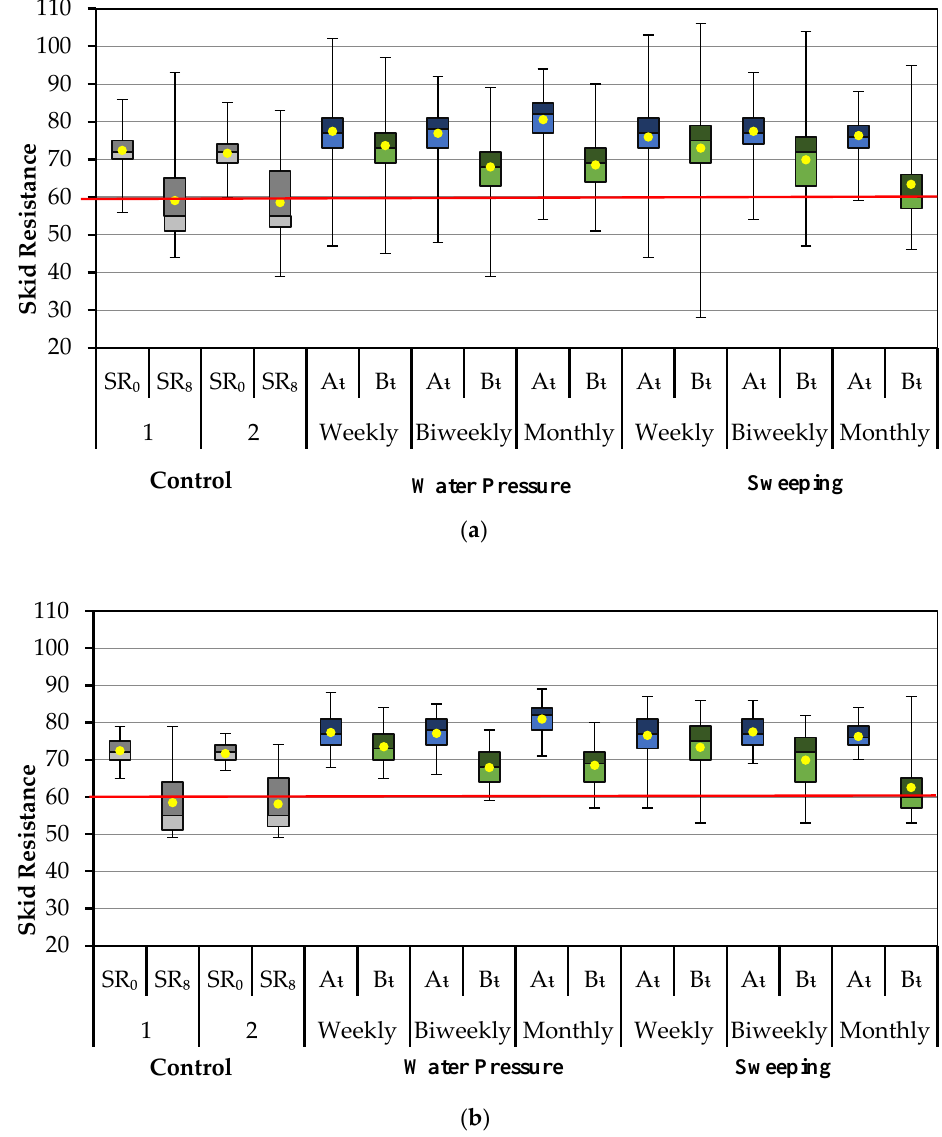
Figure 2. Box plot and whiskers of SR with ( a ) and without 5% of the outliers ( b ).